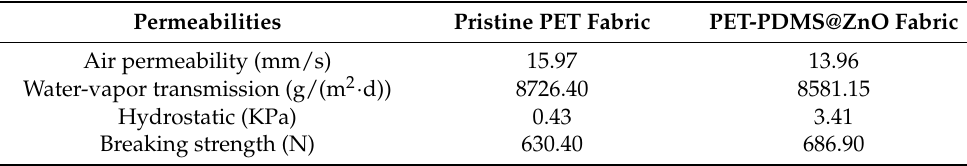
Table 1. The wearability of PET-PDMS@ZnO fabrics.